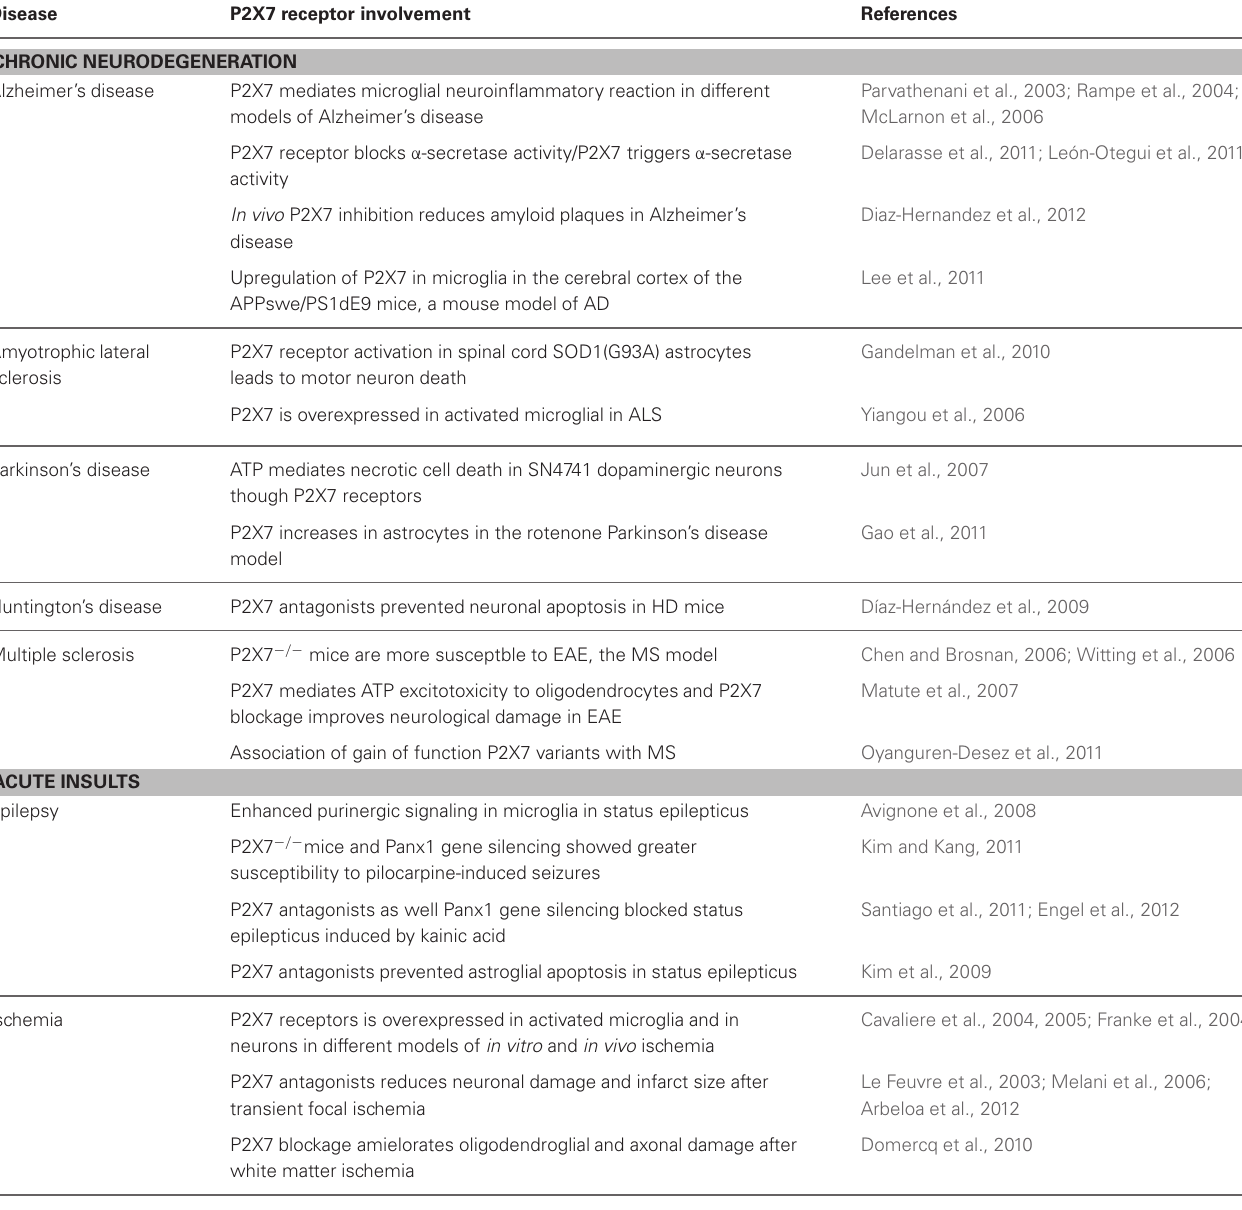
Table 2 | Neuroprotective properties of P2X7 receptor antagonists.